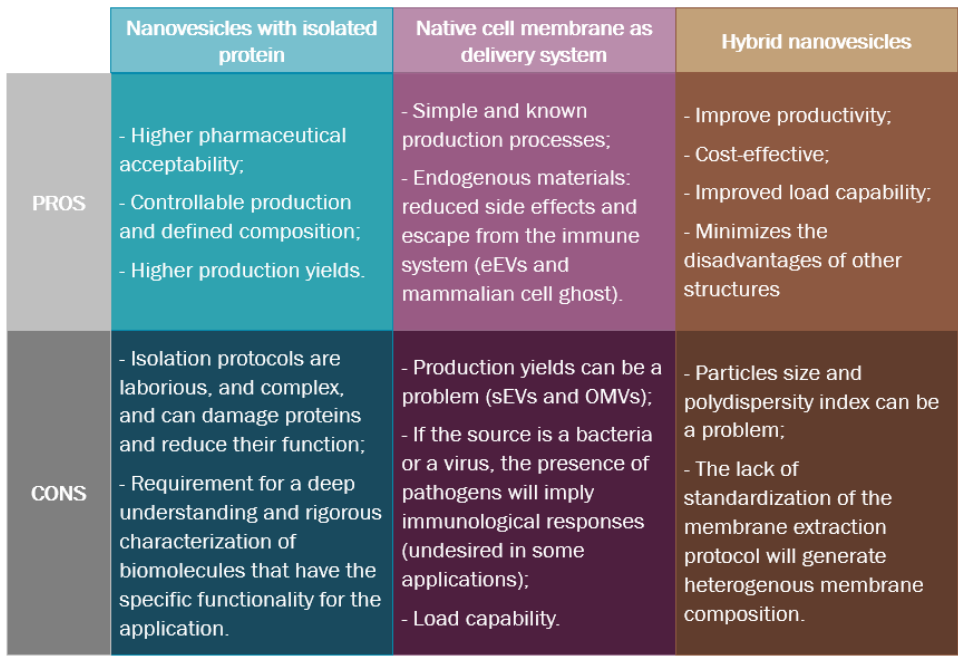
Figure 4. Advantages and disadvantages of each design strategy for biomimetic nanovesicles.